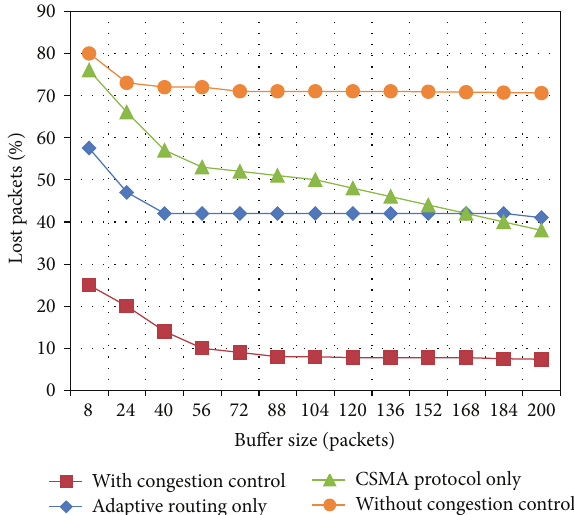
Figure 6: Network satisfaction as a function of the incoming